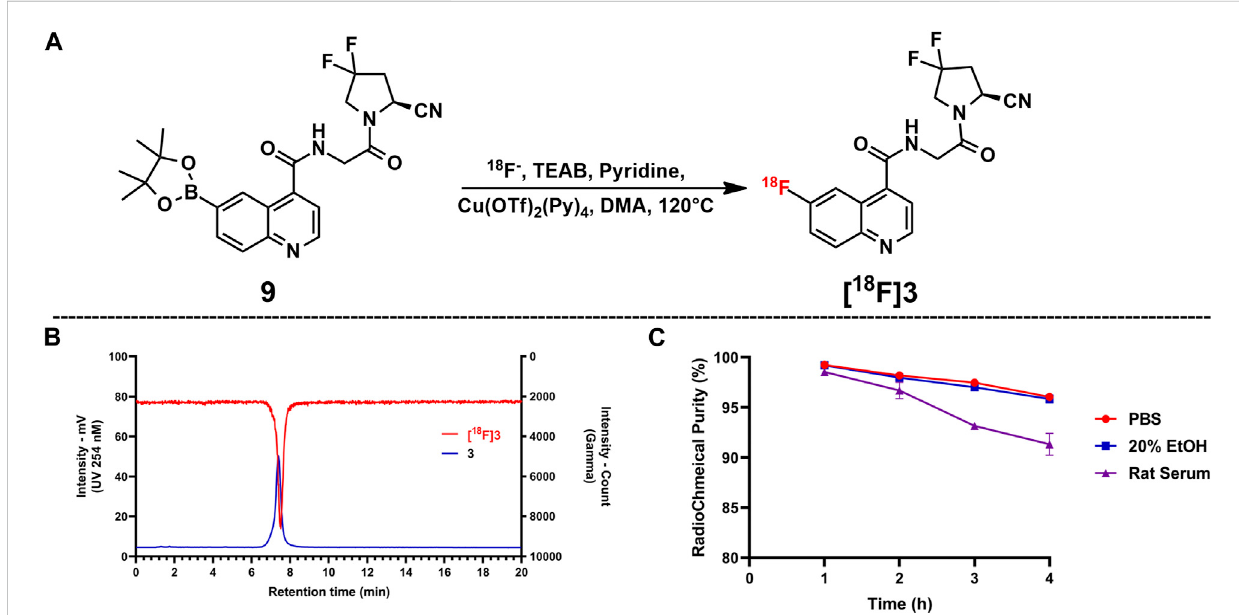
FIGURE 2 Copper-mediated S N A R radio fl uorination via the boronic ester precursor and in vitro tests for RCY and stability. (A) Radiolabeling reaction. (B) Co- injection of the reference standard (compound 3 ) and [ 18 F] 3 ; compound 3 showed a retention time of 7.40 min and that of [ 18 F] 3 was 7.48 min. (C) Radiochemical purities for all samples in the stability test; bars indicate